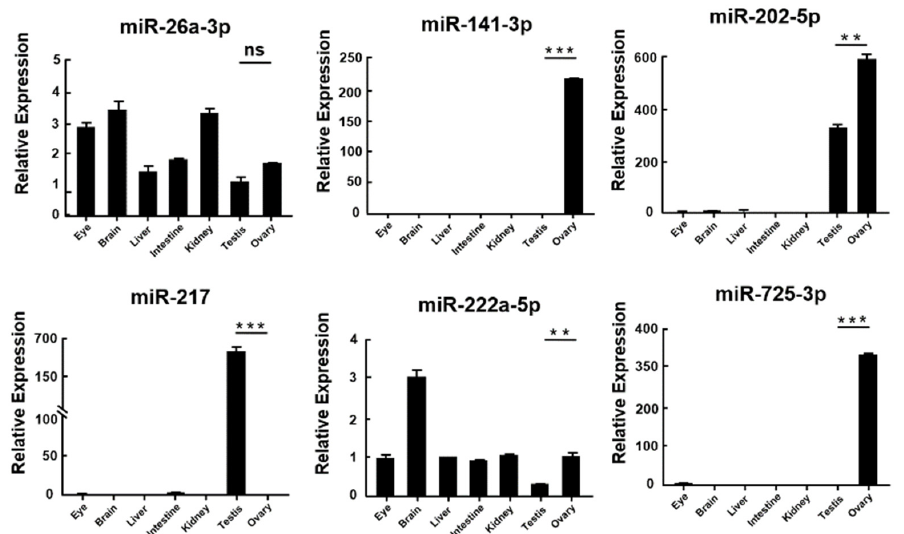
Figure 5. The relative expression of miRNAs in different tissues of A. fasciatus . The expression was calculated through comparative CT ( ∆∆ CT) methods utilizing U6 as a reference. **: 0.001 < p < 0.01; ***: p < 0.001, ns: no significance.